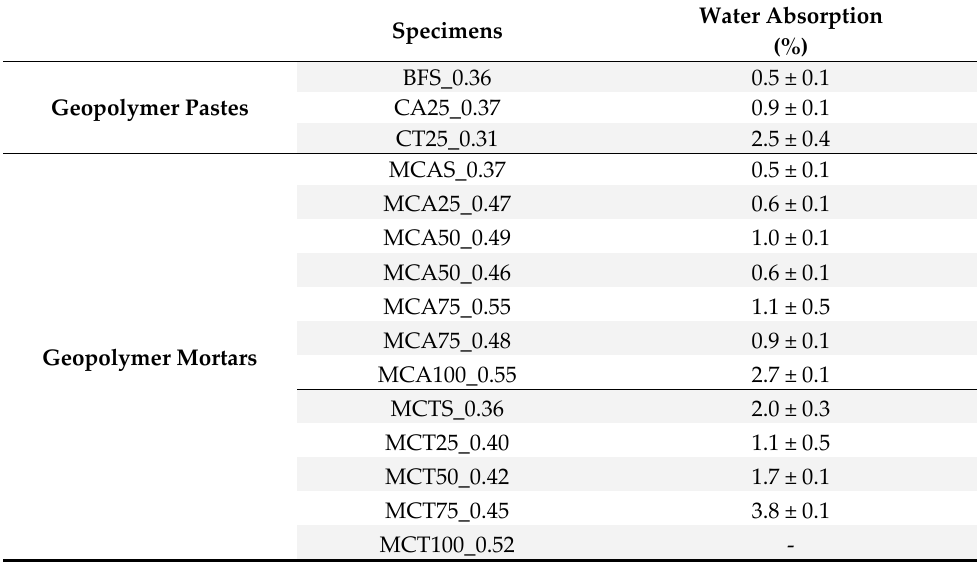
Table 5. Water absorption by immersion of the specimens with 28 days of curing.